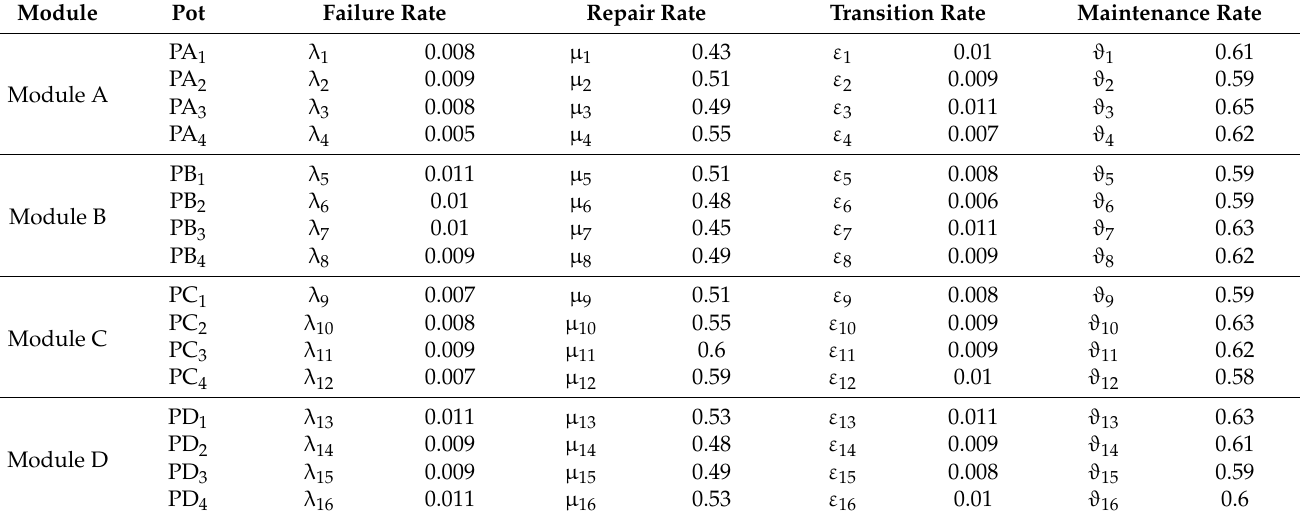
Table 1. Various factors obtained from four